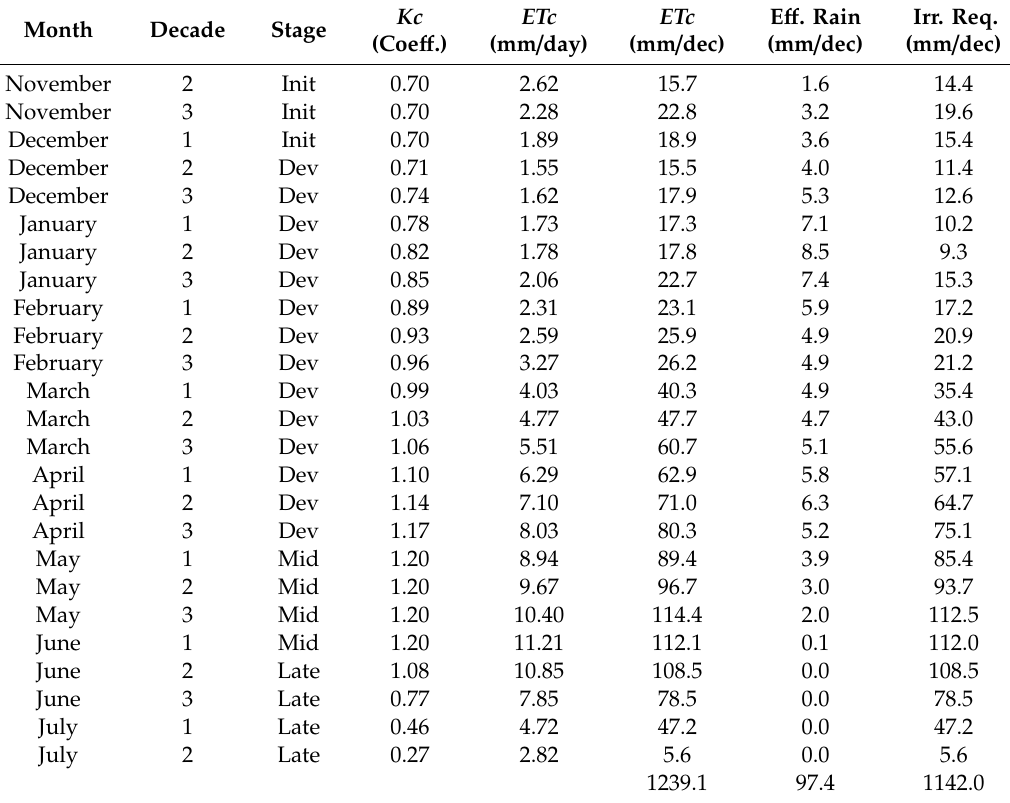
Table 3. Crop water requirement for wheat. (Init, initial; Dev, development; E ff . Rain, e ff ective rain; Irr. Req., irrigation requirements).